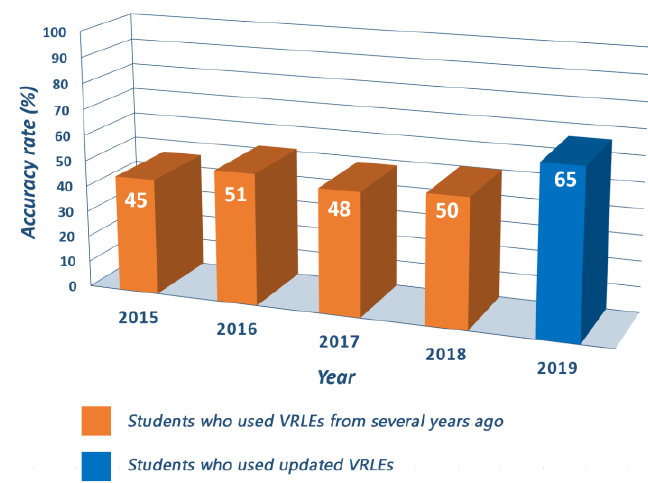
Figure 6. Accuracy rate (students’ marks) of survey questions provided by students, who participated